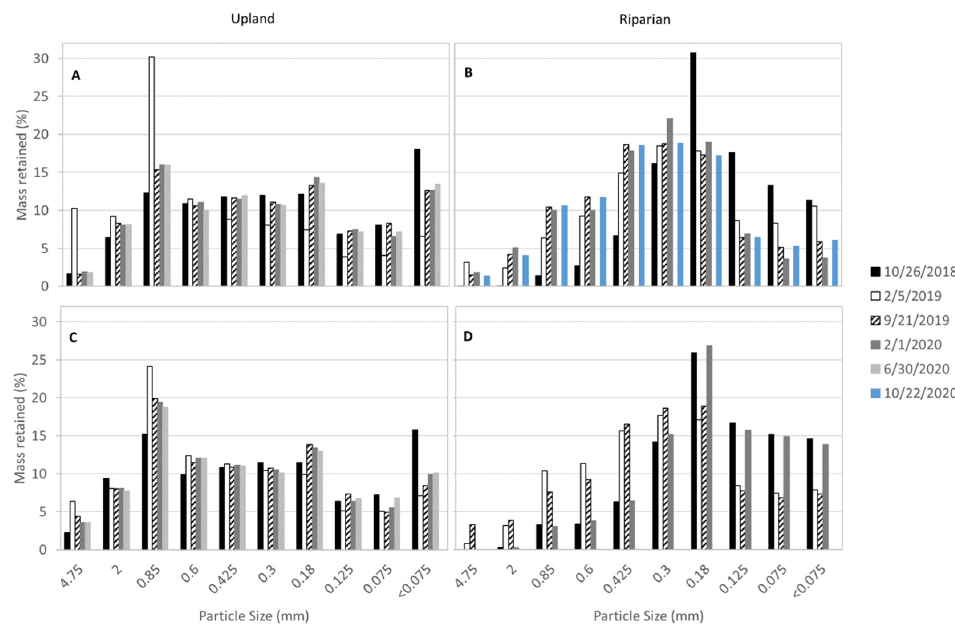
Figure 4. Percent of soil mass retained per sieve size for the ( A ) upland and ( B ) riparian upper soil depths and ( C ) upland and ( D ) riparian lower soil depths.